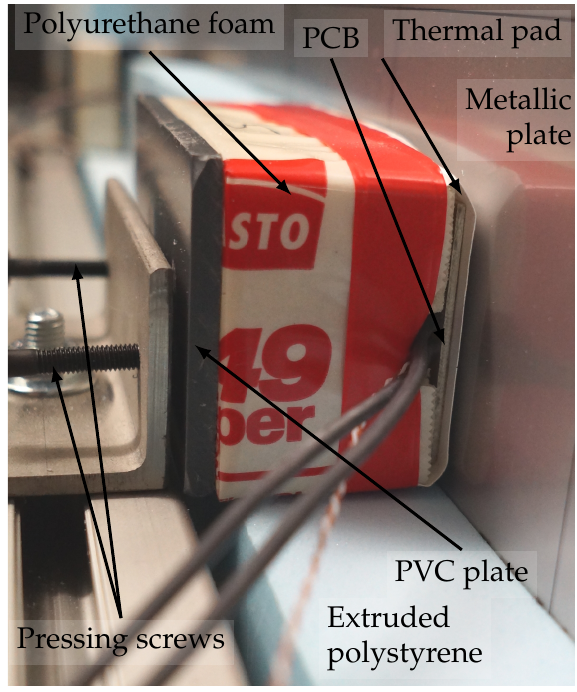
Figure 3. One of the heat sources mounted on the back of the metallic